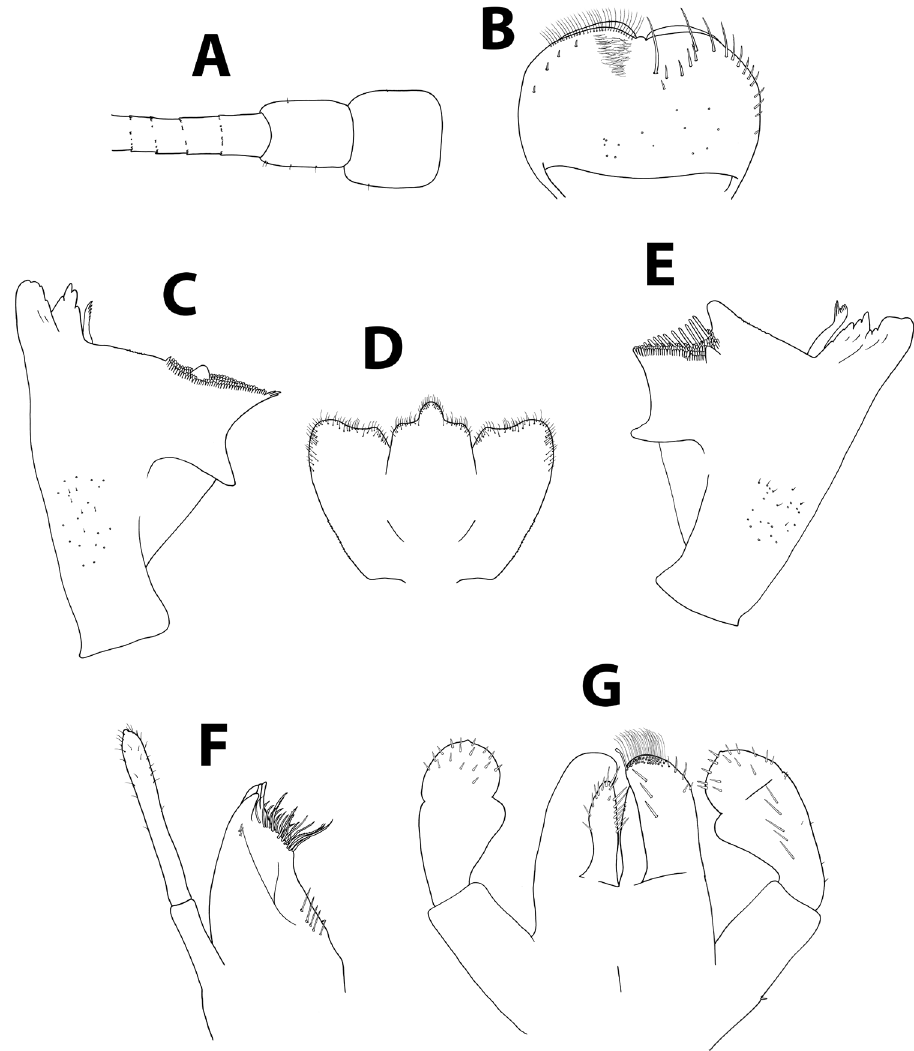
Figure 16. Baetis samochai , nymph. A antennal scape, pedicel and first flagellomeres B labrum (left, ventral; right, dorsal) C right mandible D hypopharynx E left mandible F maxilla G